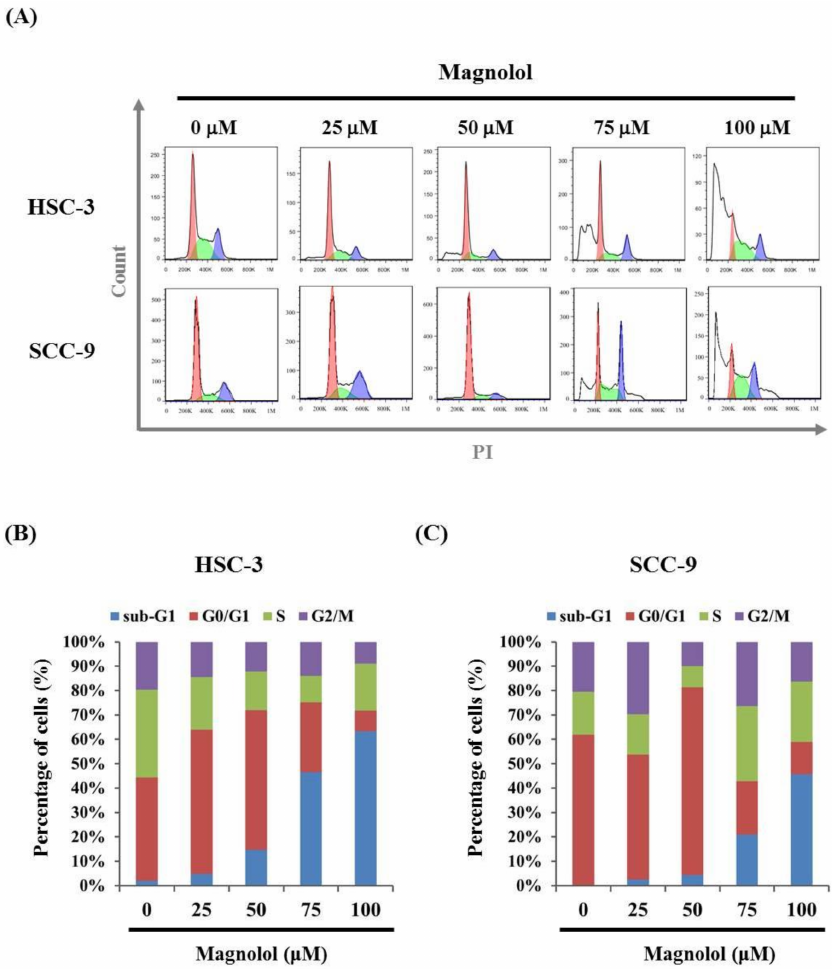
Figure 2. Effects of magnolol on the cell-cycle phase distribution of HSC-3 and SCC-9 cells. ( A ) After treatment with magnolol (0, 25, 50, 75, 100, and 150 µ M) for 24 h, the cell-cycle phase distribution in the HSC-3 and SCC-9 cells was evaluated by flow cytometry assay, as described in the Materials and Methods section. Quantitative cell-cycle phase distribution indicated that sub-G1 arrest was induced by magnolol on ( B ) HSC-3 cells and ( C ) SCC-9 cells in a dose-dependent